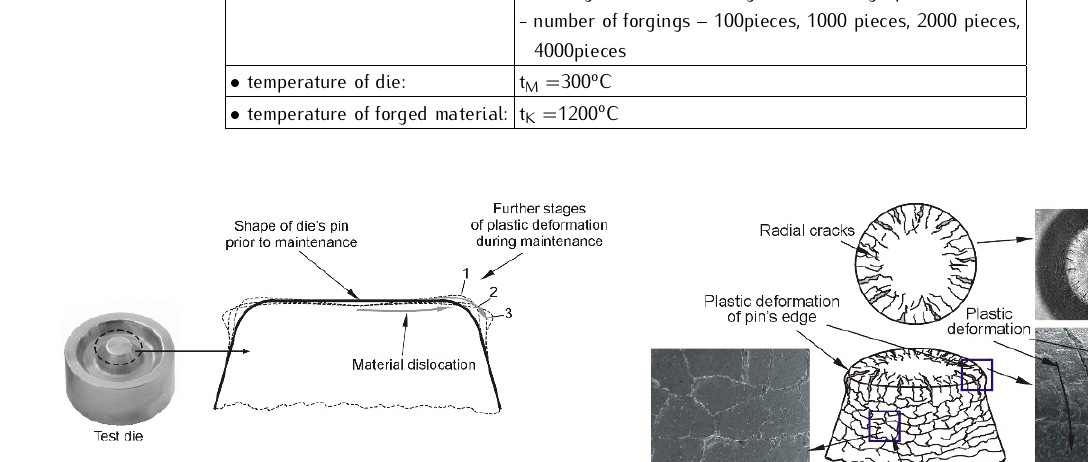
Figure 5. Further stages of plastic deformation of the forging die tested during the forging process. can be observed. Only as a result of further maintenance does the hardness decrease. The change of hardness for dies covered with 1 µ m, 2 µ m and 8 µ m coatings are of ex- ponential character and strive to the level of ca 400HV that corresponds to the hardness of the bulk material. A different character of hardness changes in the zone near the surface of dies covered with 4 µ m thick CrN coating